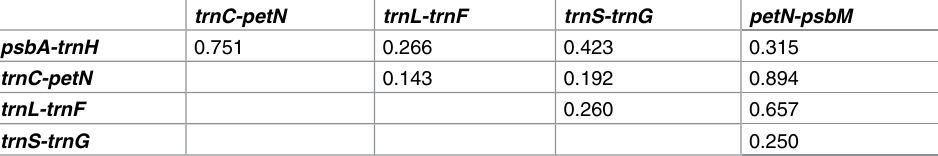
Table 3. P values of pairwise ILD tests for the plastid psbA-trnH , trnC-petN , trnL-trnF , trnS-trnG and petN-psbM